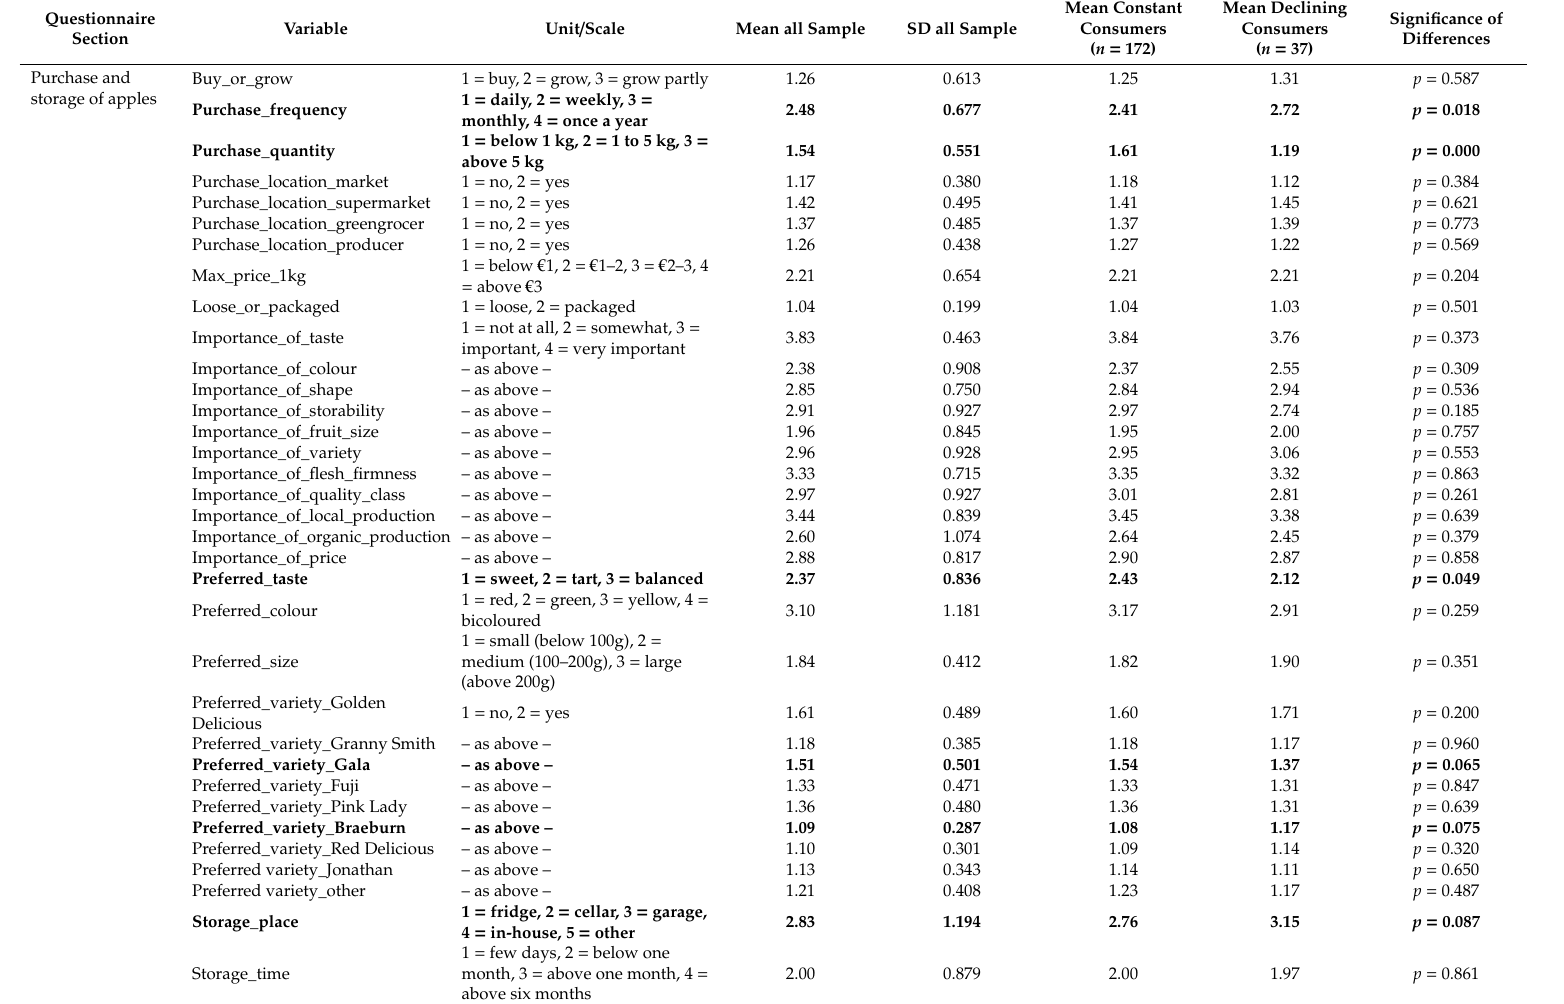
Table A1. Variables used in the consumer survey and descriptive